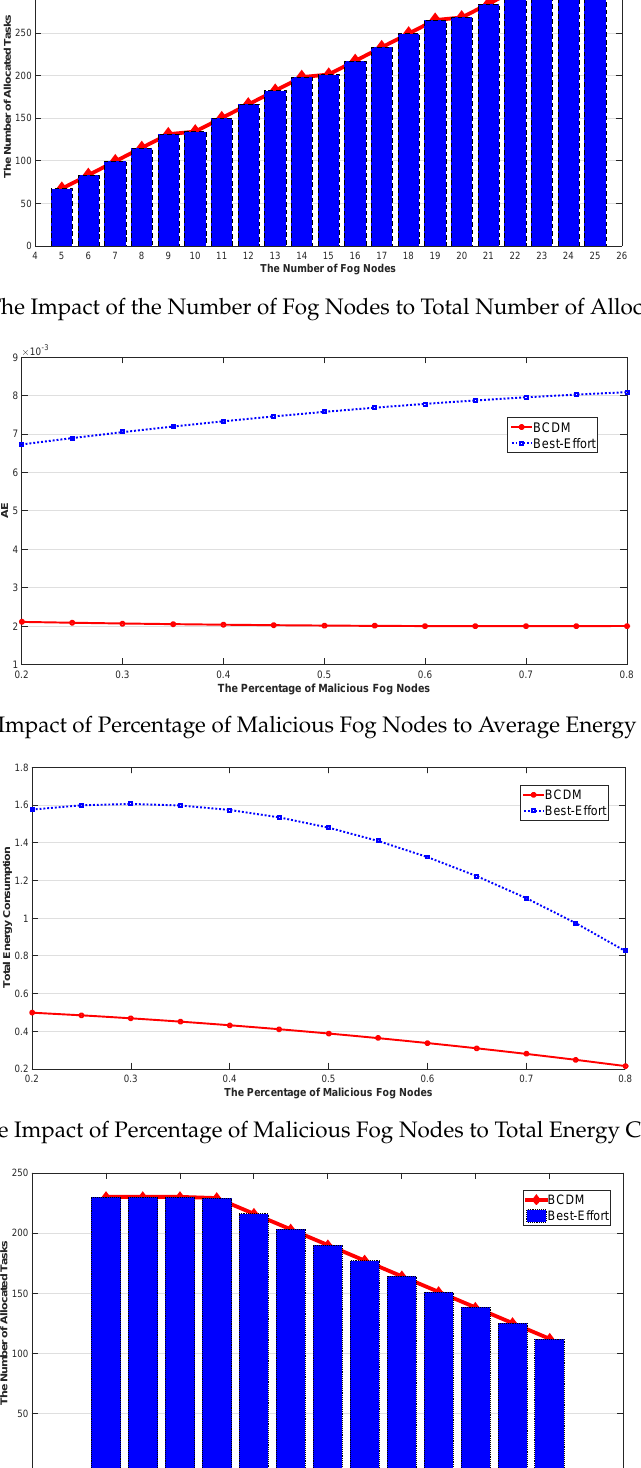
0.1 The Percentage of Malicious Fog Nodes Figure 17. The Impact of Percentage of Malicious Fog Nodes to Total Number of Allocated